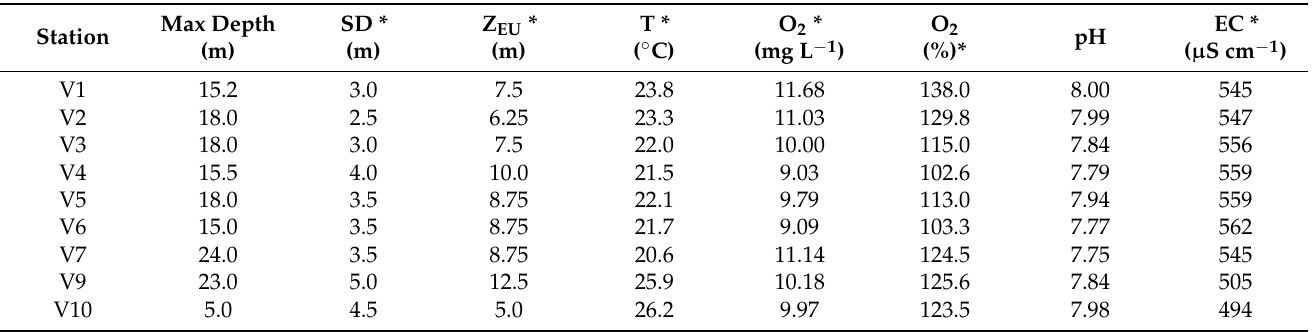
Table 1. Environmental variables on 9 sampling stations (V1 to V10, excluding station V8) for composite